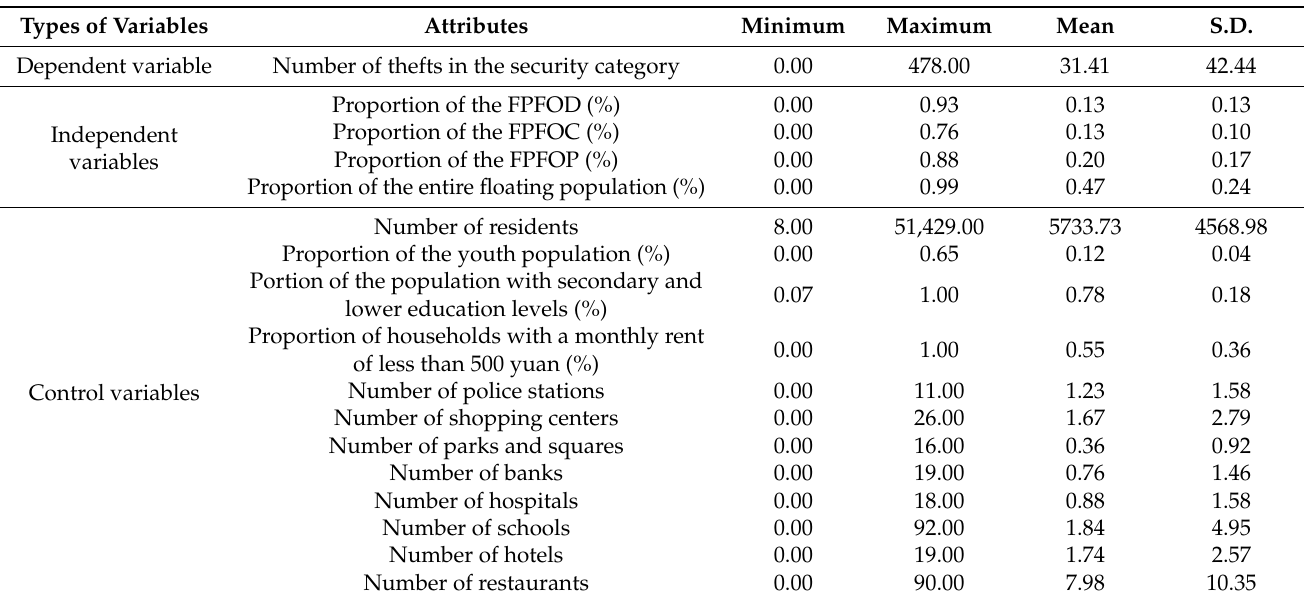
Table 1. Descriptive statistics of